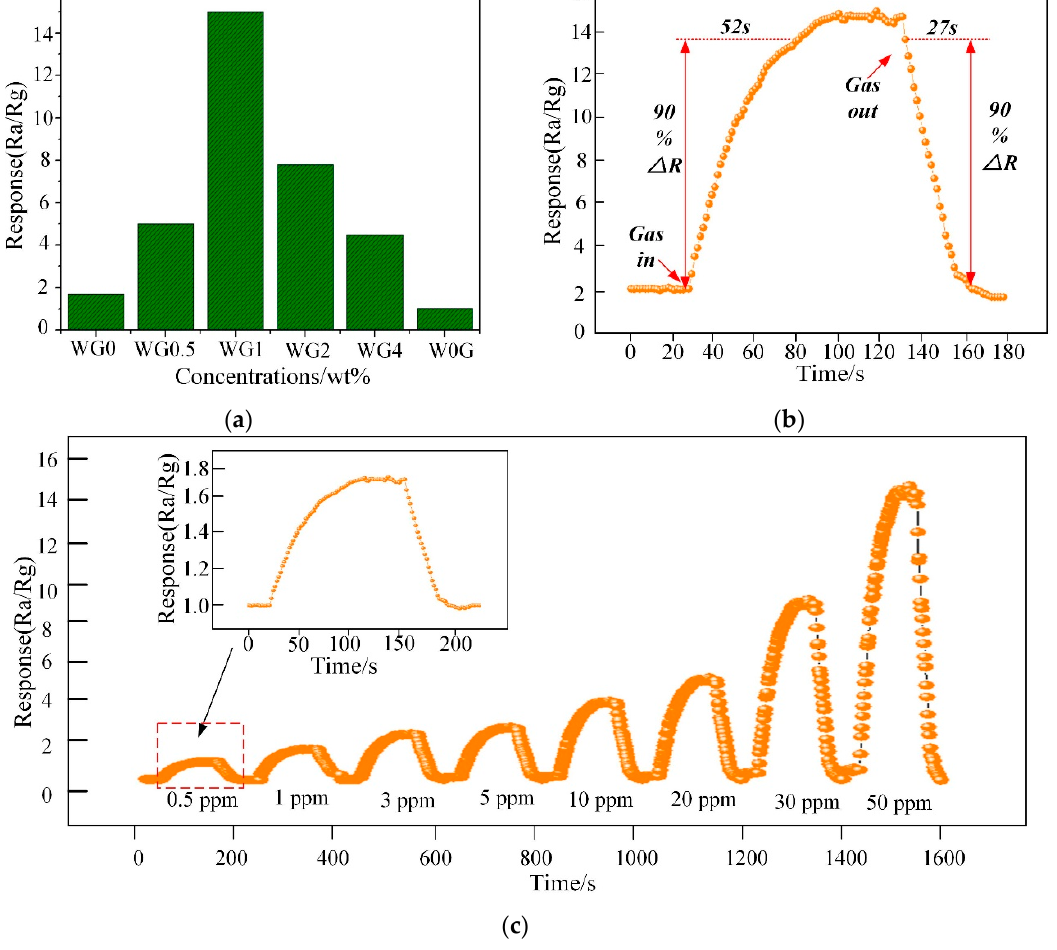
Figure 11. ( a ) Sensor response variation for 50 ppm C 2 H 2 at 150 °C; ( b ) Dynamic sensing transient of WG1 senor to 50 ppm C 2 H 2 gas; and, ( c ) Response under different gas concentrations from 0.5 ppm to 50 ppm for C 2 H 2 of WG1 at 150 °C.